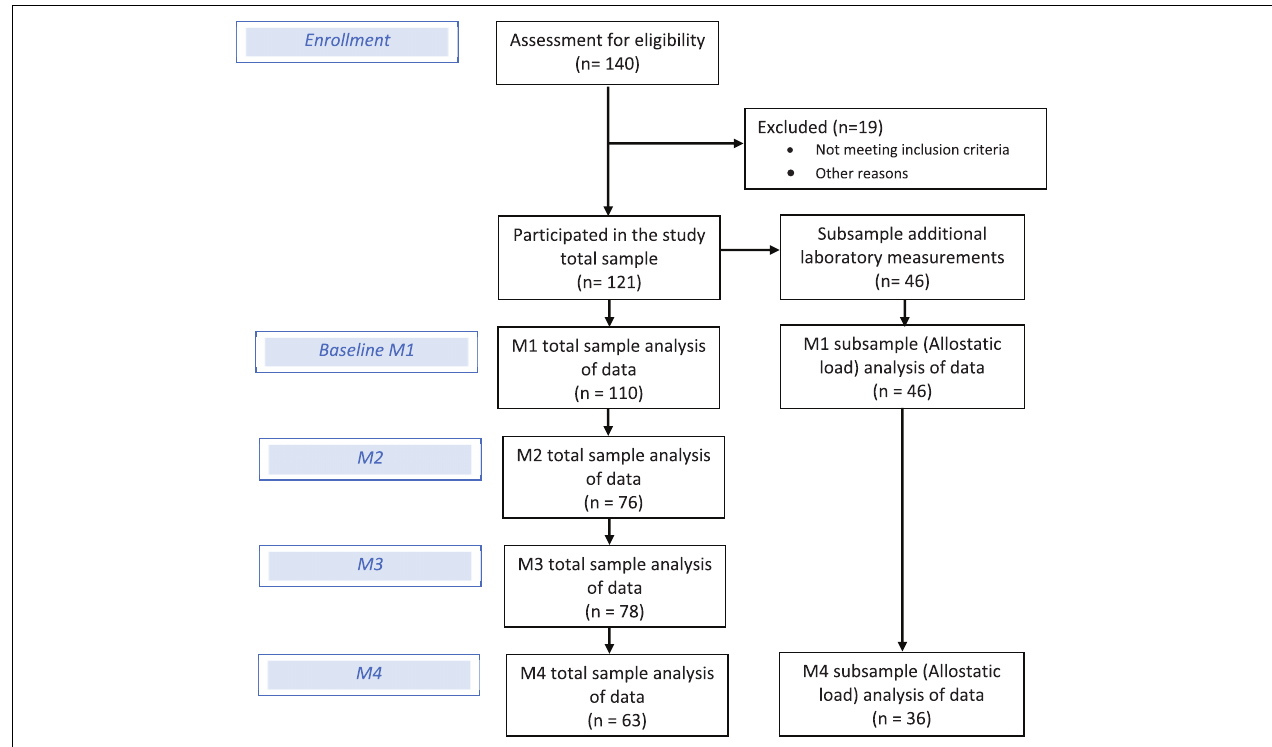
FIGURE 1 | Flow diagram of participants and sample analyzed